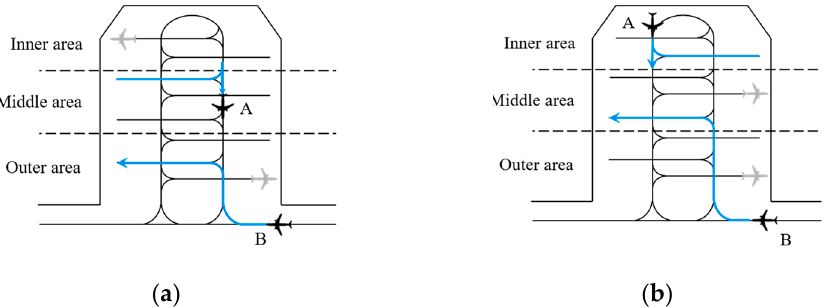
Figure 5. Partition-Shared Operation Procedure. Blue arrows indicate the aircraft operation path. ( a ) shows a scenario where there are departure aircraft A being pushed back from the inner or middle area and arrival aircraft B entering the outer area at the same time. ( b ) shows a scenario where there are departure aircraft A pushing out from the inner area and arrival aircraft B entering the middle or outer area at the same time.